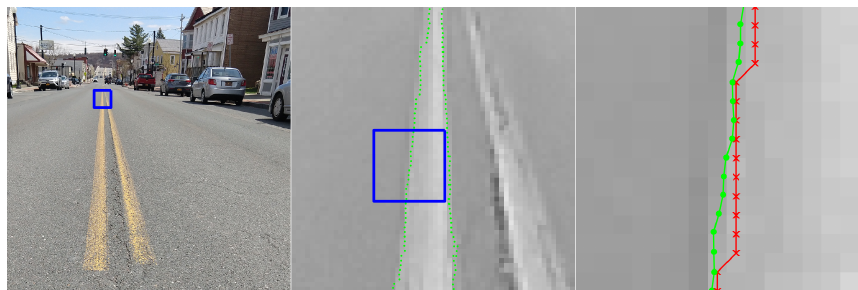
Figure 12. Image of a street in Watervliet, NY, where we seek to localize the edges of the painted yellow lane markings. The red symbols denote pixel-level edge estimates and green dots denote the refined × subpixel localization estimates. Original image collected by the authors with a personal camera.